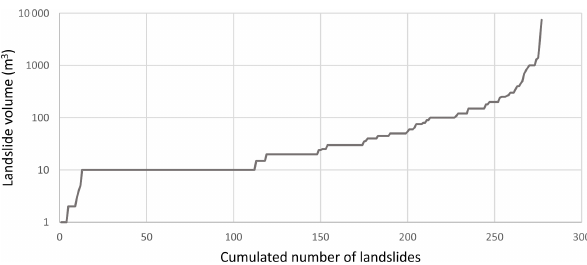
Figure 7. Cumulated frequency distribution of the 277 landslides with volumetric